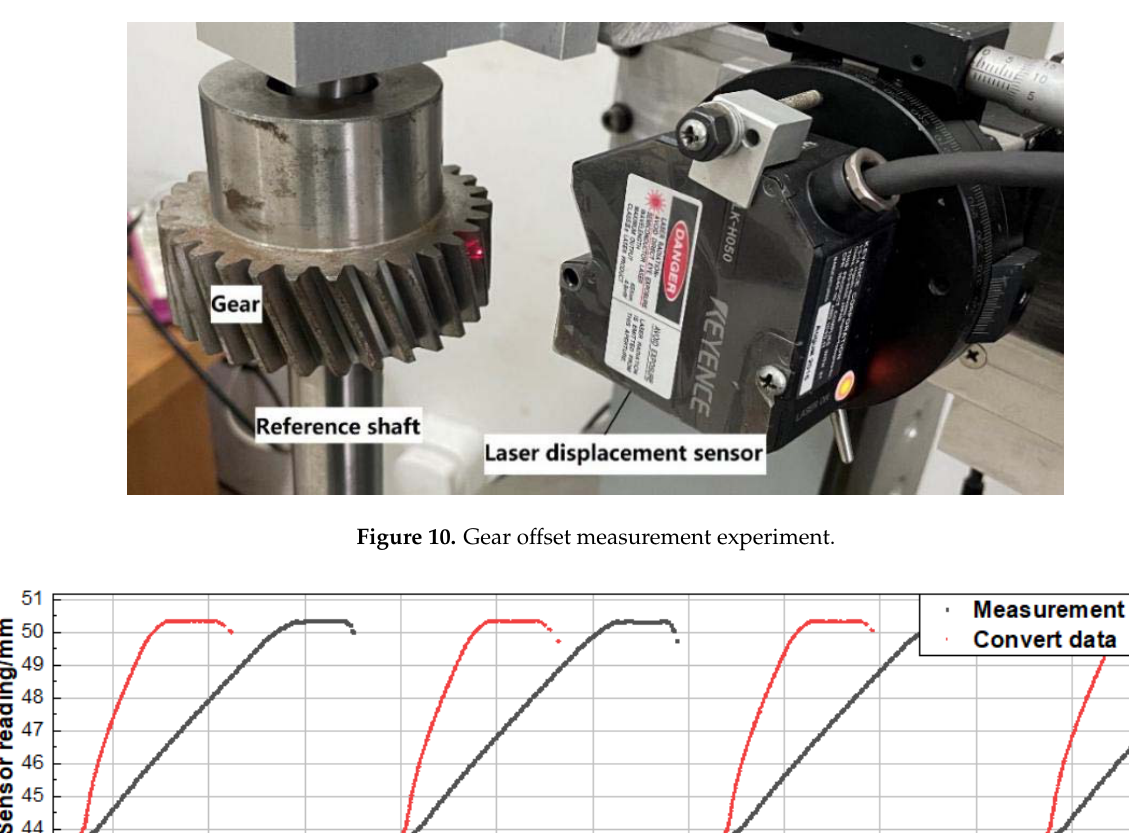
Figure 10. Gear offset measurement experiment.